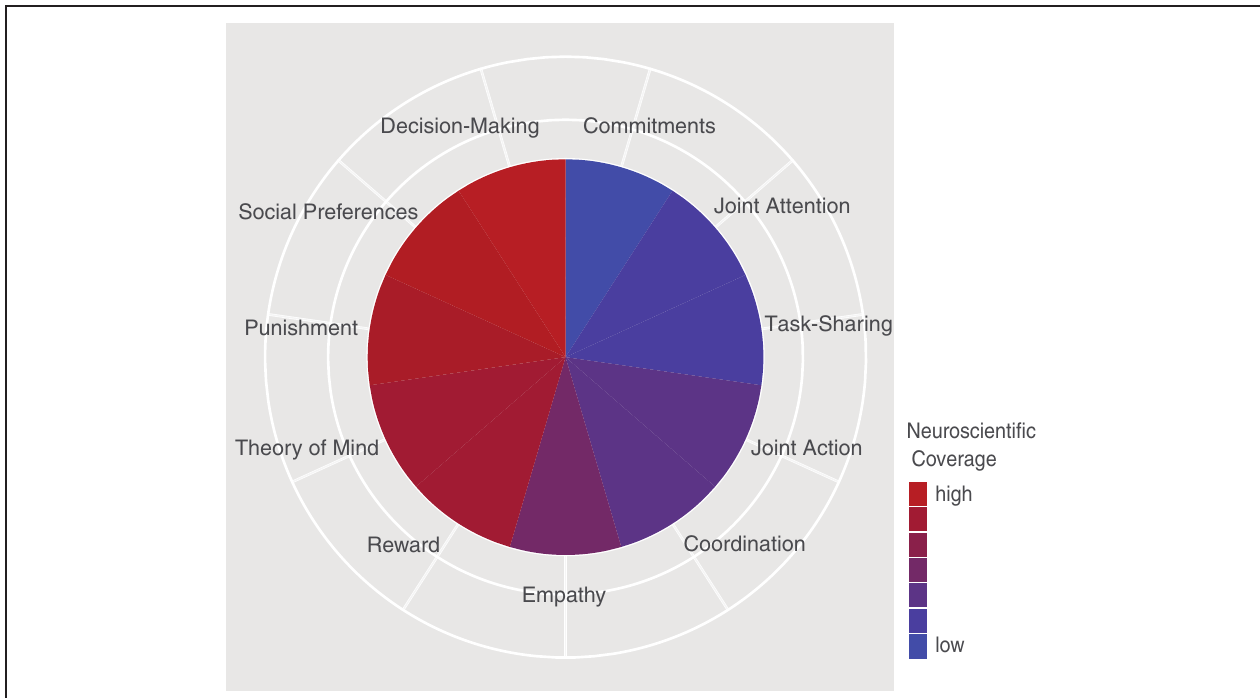
The measures are based on the authors’ subjective impression rather on any objective measure given general inconsistencies in nomenclature and diverging experimental settings throughout existing research on